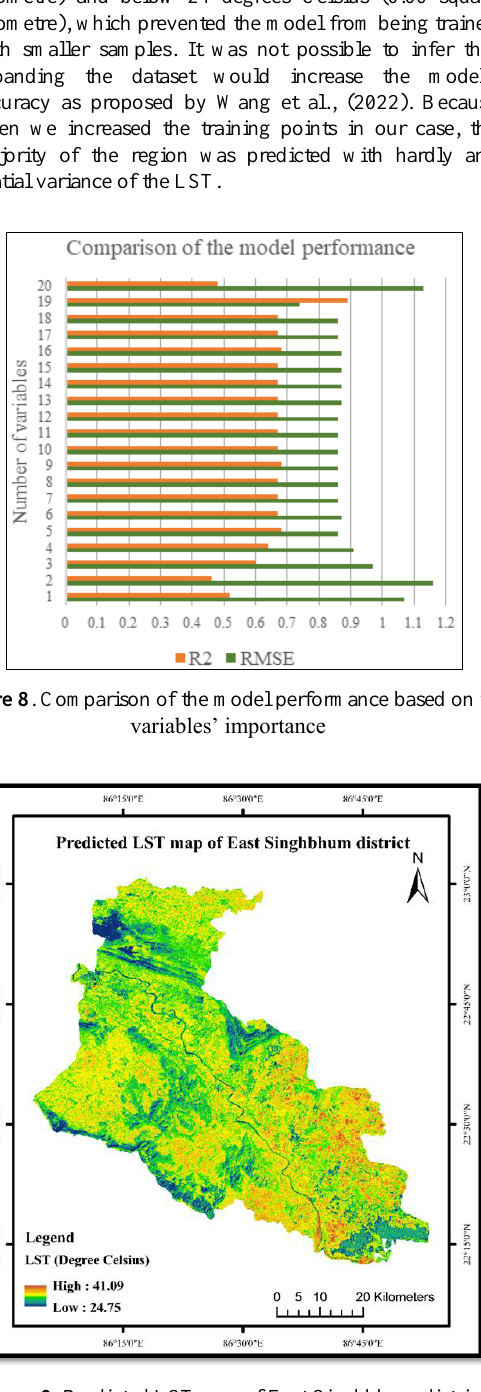
Figure 9 . Predicted LST map of East Singhbhum district using RF